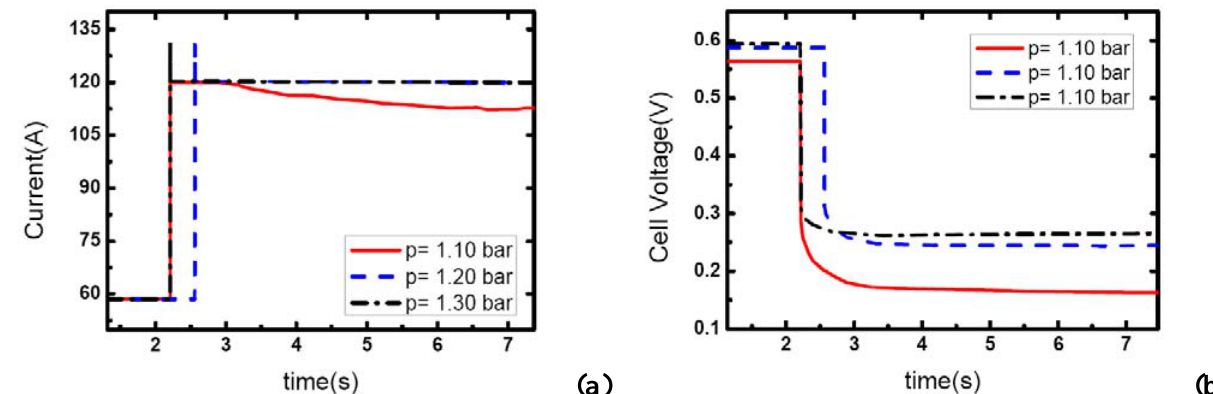
Figure 8. (a) Current change at three different operating pressures while λ to 1.95, (b) corresponding dynamic responses of voltage.